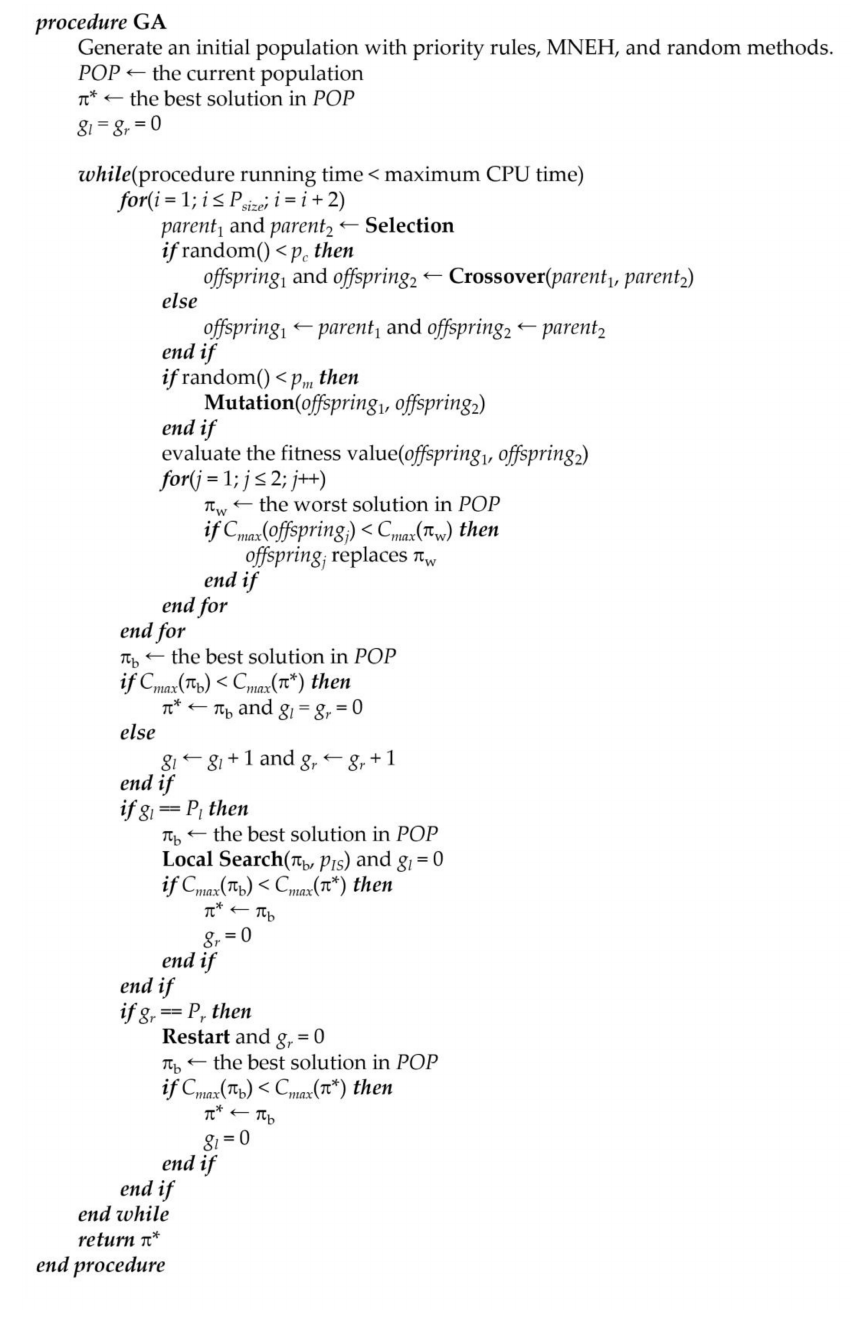
Figure 3. Proposed genetic algorithm